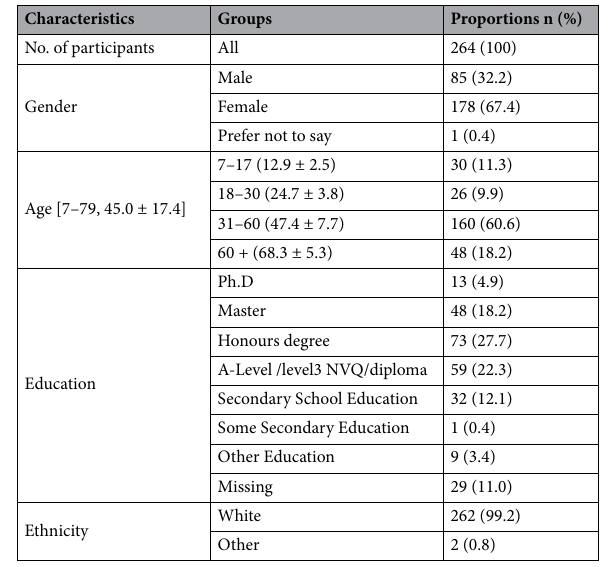
Table 1. Characteristics of study participants. The values for age are presented in the range, mean ± standard deviation